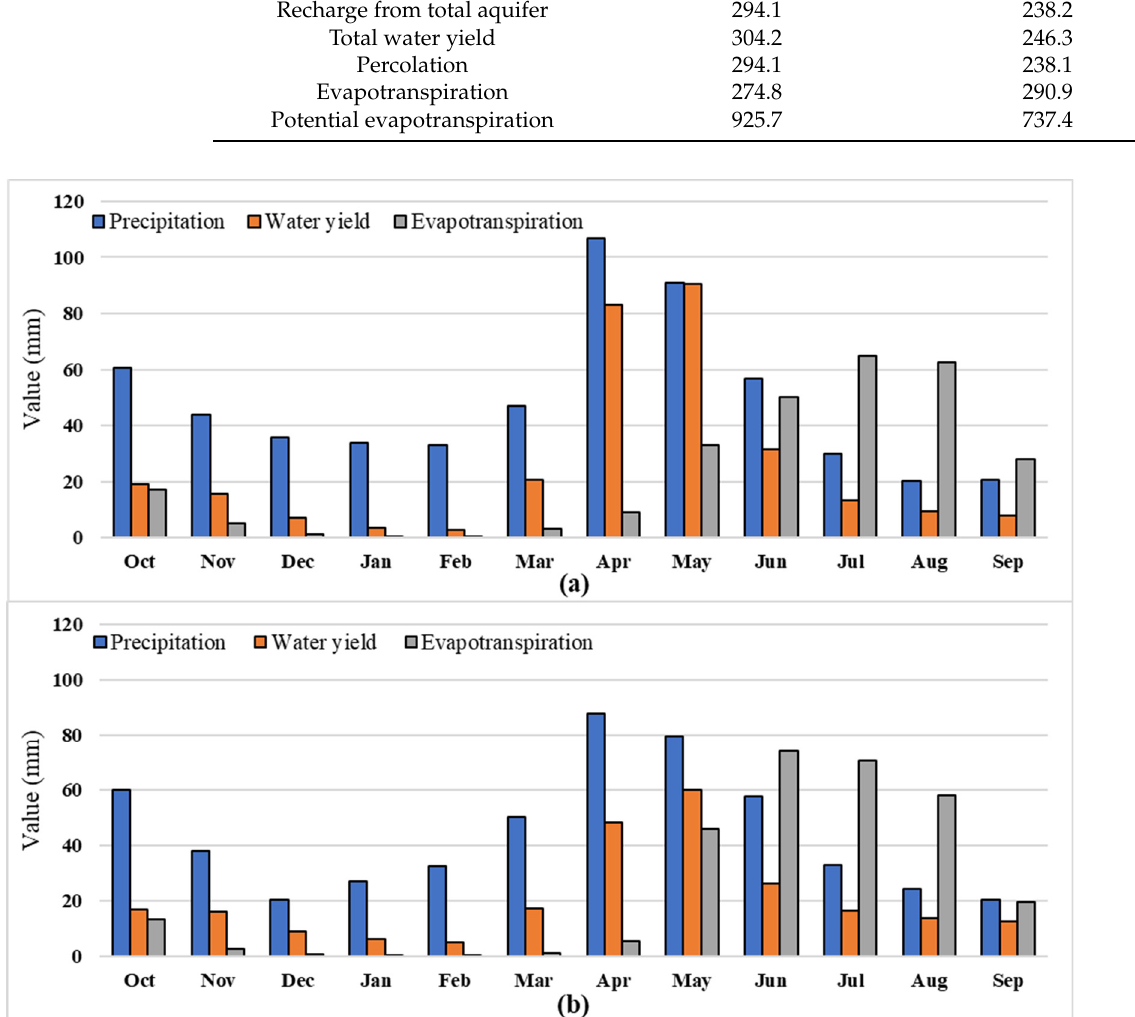
Figure 6. Average monthly values of precipitation, water yield and evapotranspiration for ( a ) Murat and ( b ) Karasu ba- sin.